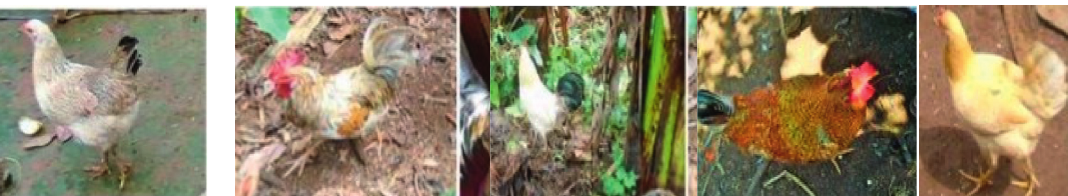
Figure 5: White-barley, golden-red, black-tailed white, silver and buff/yellow, and indigenous ecotypes. Source: Hailu and Melese,